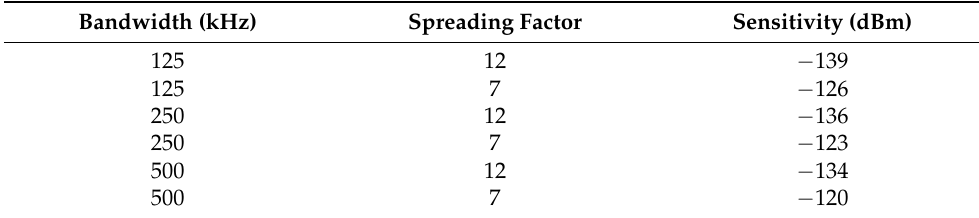
Table 5. Receive sensitivity threshold of the LoRaWAN Gateway used in an experiment.